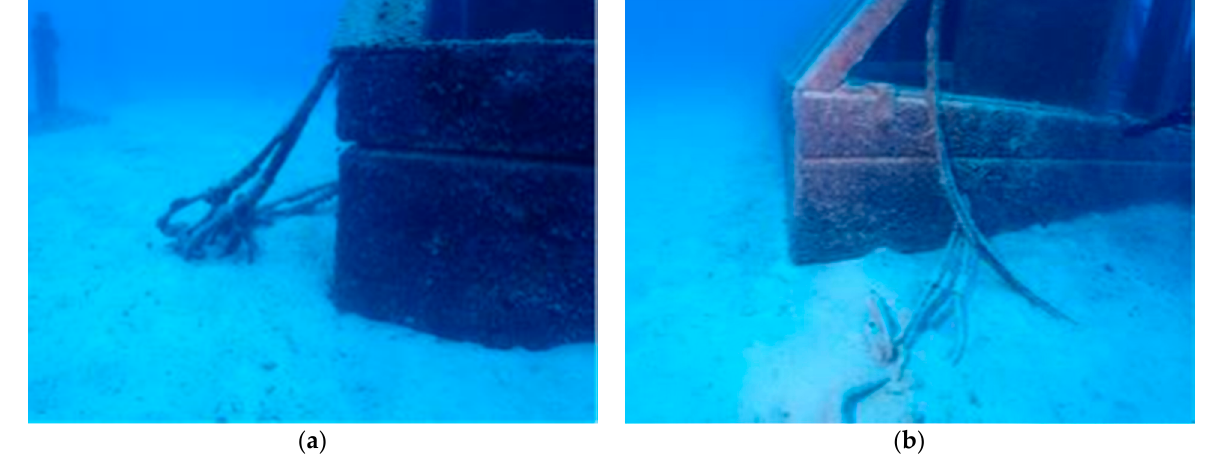
Figure 5. Coral Greenhouse foundation corners—( a ) West; ( b ) South. Table 2. Coral Greenhouse corner seabed measurements—difference from top of base frame to seabed (unit: mm).